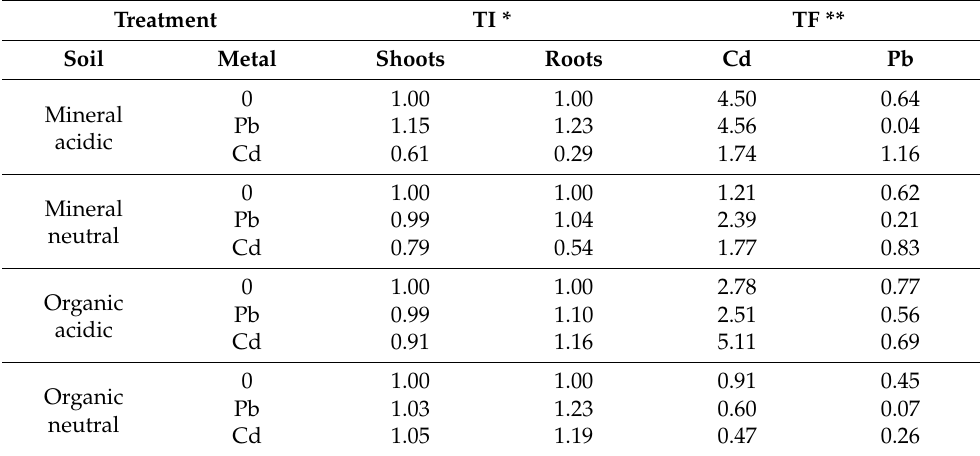
Table 2. The indices of Fagopyrum esculentum tolerance to Cd and Pb when grown in different soils.